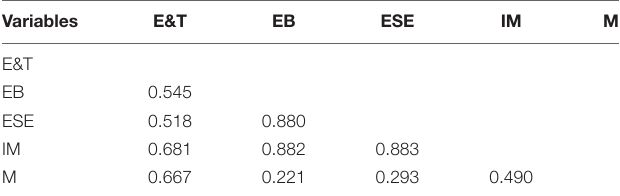
TABLE 2 | Measurement model and descriptive statistics.